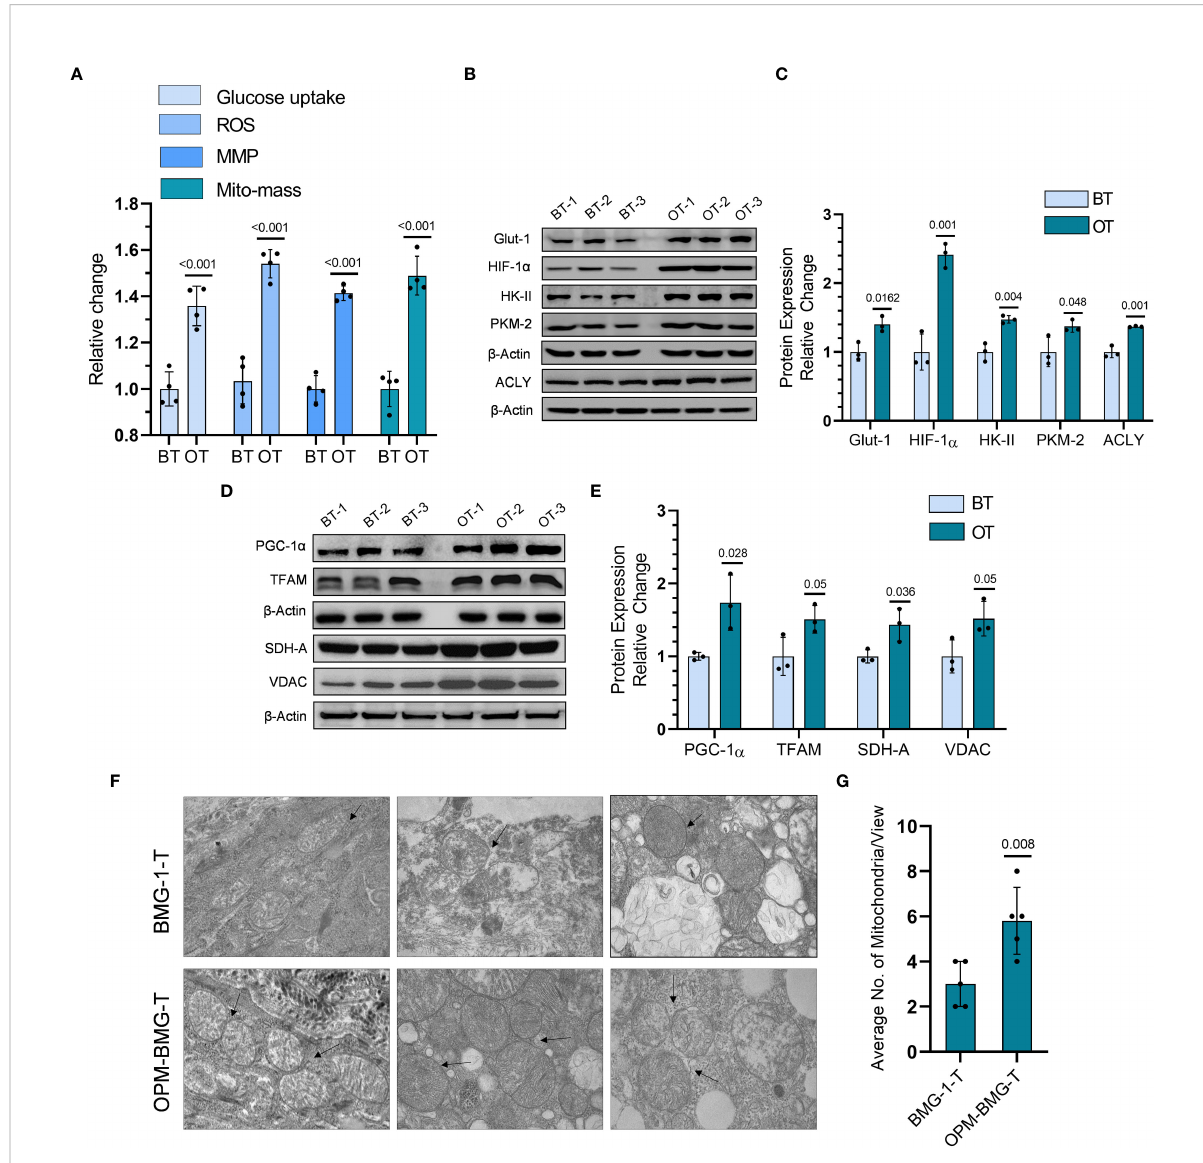
FIGURE 5 Tumor bioenergetic pro fi le revealed coexisting hyper-metabolism in the OPM-BMG xenografted tumor. (A) Glucose consumption, ROS, MMP, and mitochondrial mass (Mito-mass) were estimated in BMG-1 tumor (BT) and OPM-BMG tumor (OT) samples at 25 th -day post-implantation (n=4mice/group) using fl uorescent probes 2NBDG [100 m M ], CM-H2DCFDA [10 m M], DiOC6 [100nM] and Mito Tracker Green [100nM] respectively and presented as relative change among the BT and OT samples. (B, C) . BT and OT samples were subjected to immunoblotting on (the 25 th day; n=3 mice/group), and the expression pro fi le (B) with the relative densitometric evaluation (C) presented among the groups. (D, E) . In a similar experimental condition, representative expression of indicated mitochondrial proteins (D) and relative change (E) are presented in the BT and OT sample (n=3 mice/group). (F, G) . TEM images were obtained from different BT and OT samples on the 25 th day post- implantation, with arrows indicating the difference in the number of mitochondria/view (F) and a bar plot showing the average numbers of mitochondria (n=5; (G) . Data are expressed as the mean ± SD; P -values (BMG-1 versus OPM-BMG tumor samples) are mentioned in the